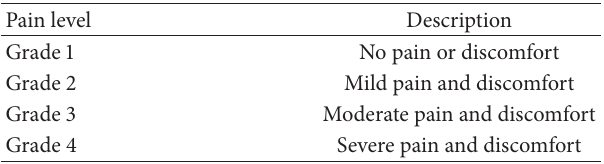
Table 1: Visual analogue pain scale